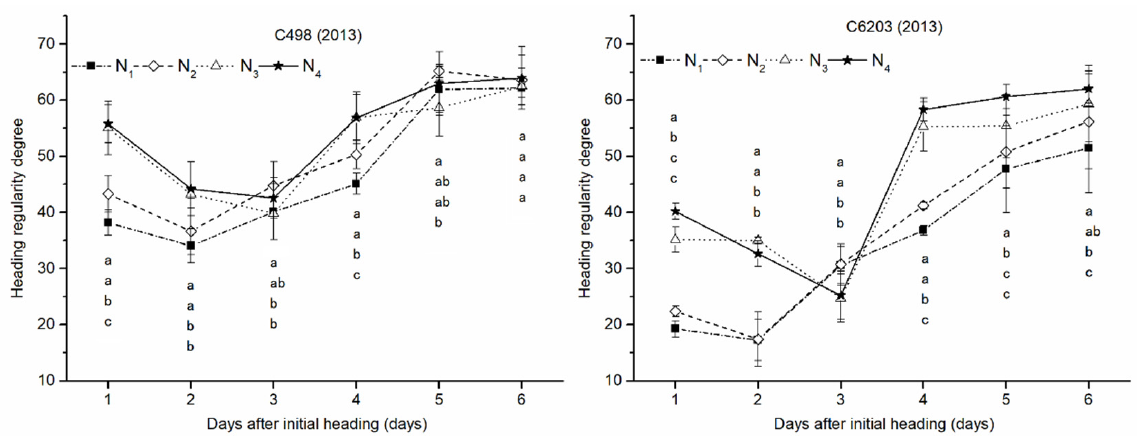
Figure 1. Dynamic changes in the rice heading uniformity over six days after the initial heading in the year 2013. N1, N2, N3, and N4 represent the ratios m (base and tillering fertilizer): m (panicle fertilizer) = 75:25, 60:40, 45:55, and 30:70, respectively; vertical bars represent means ± SEs. Four groups of letters from top to bottom in the same column indicate statistical significance at p = 0.05 among different nitrogen management regimens from large to small within the same time period.